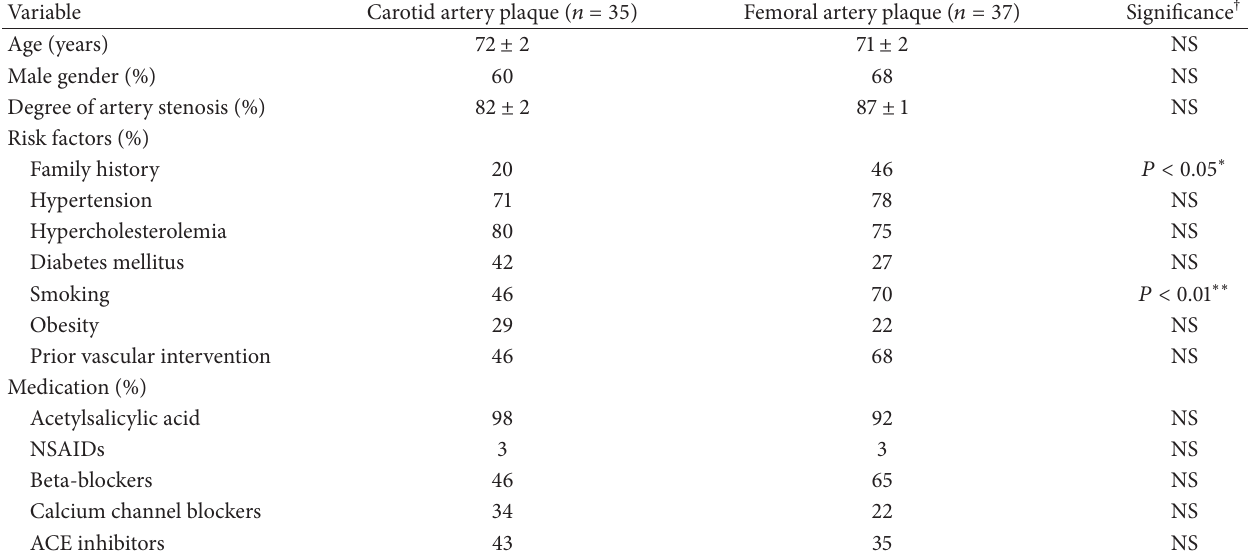
Table 1: Patient